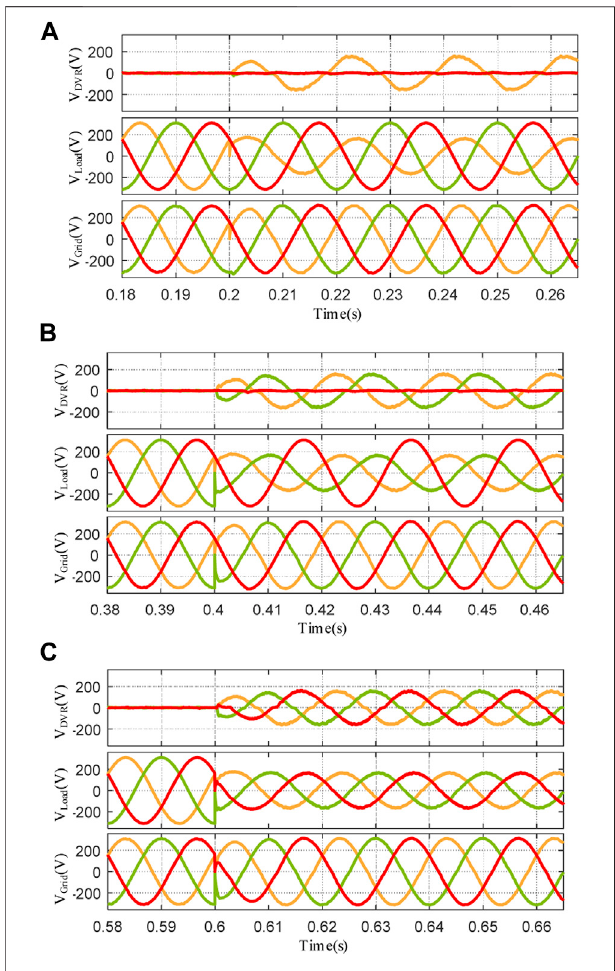
FIGURE 12| Simulation results of (A) single-phase, (B) dual-phase, and (C) three-phase voltage sag compensation for the DVR.